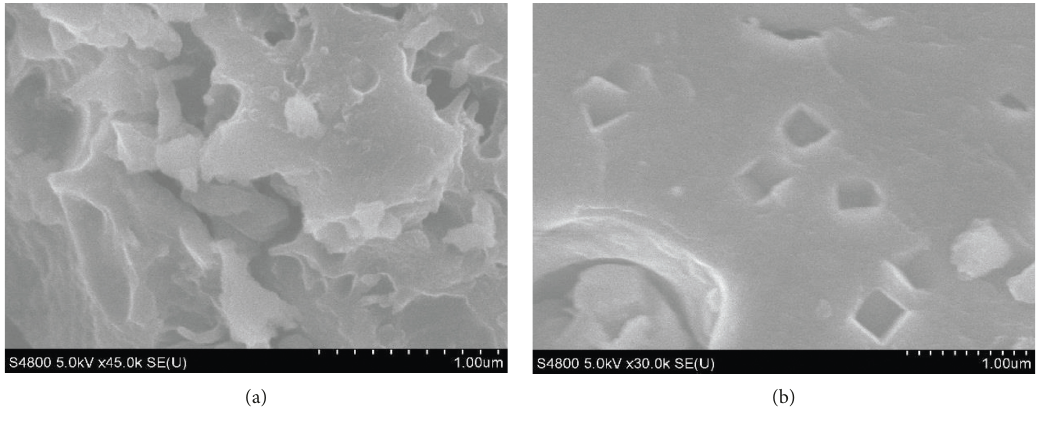
Figure 6: SEM images of CBK